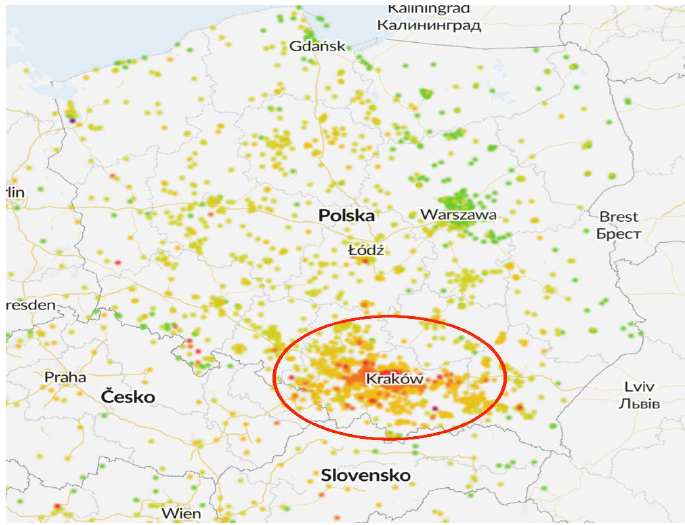
Figure 9. Poland air quality concentration map on 9 March 2022. Source: Snapshot of the Map of Air Quality by Airly: https://map.airly.org/ [112] (accessed on 10 March 2022)). Green color: good air quality (low level of pollutants). Yellow color: medium air quality (medium level of pollutants. Orange color: low air quality (high level of pollutants). Red color: very low air quality (very high level of pollutants).